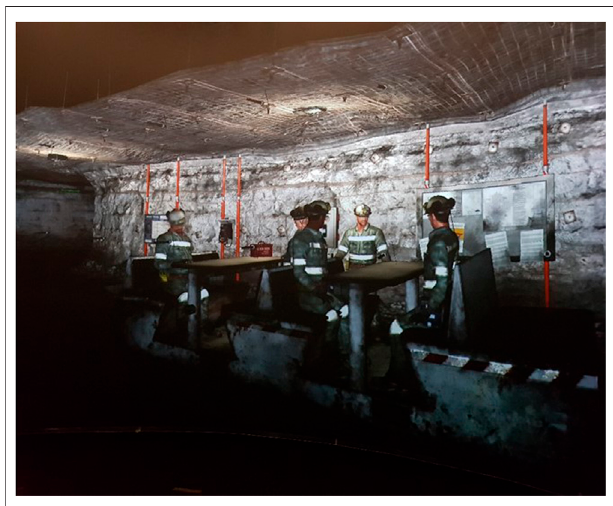
FIGURE 5 | The trainees in the 360-VR environment, with the active scenario in the